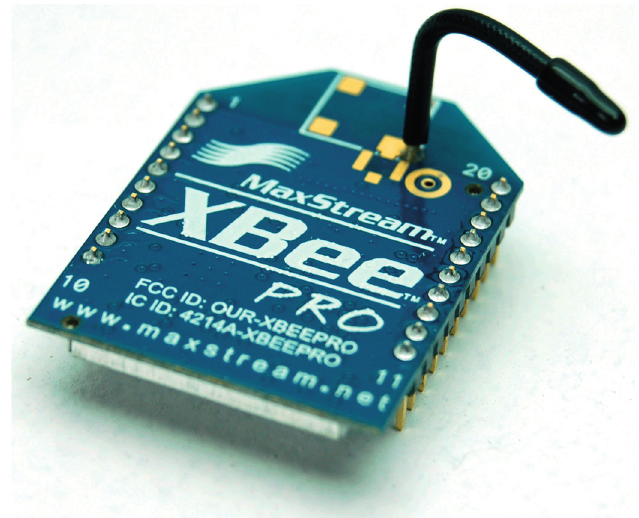
Figure 5. The XBee Transceiver